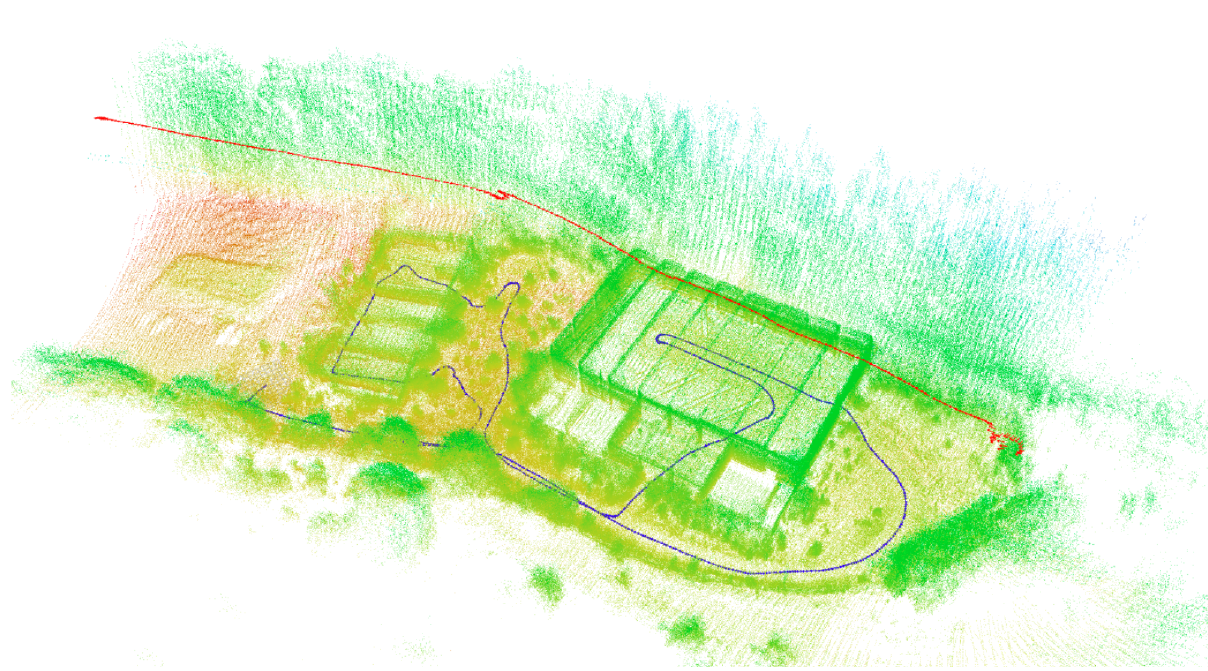
Figure 12. Map of rural wooded area with two workshop halls generated by a team of UGV /